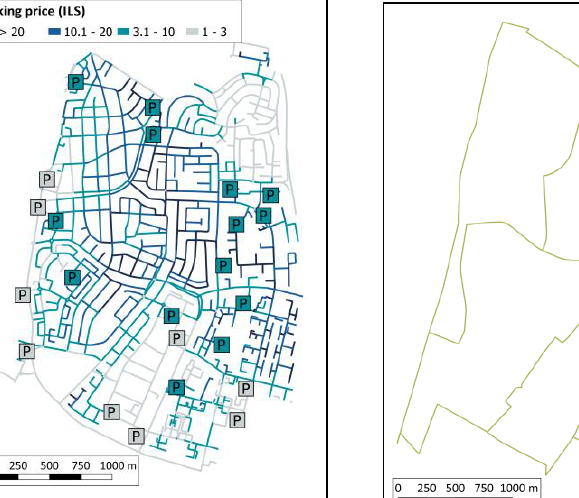
Figure 6. The percentage of time that street segments are fully occupied (left); the average parking search times (middle); and the probability to cruise for over 5 minutes (right) in Bat Yam.